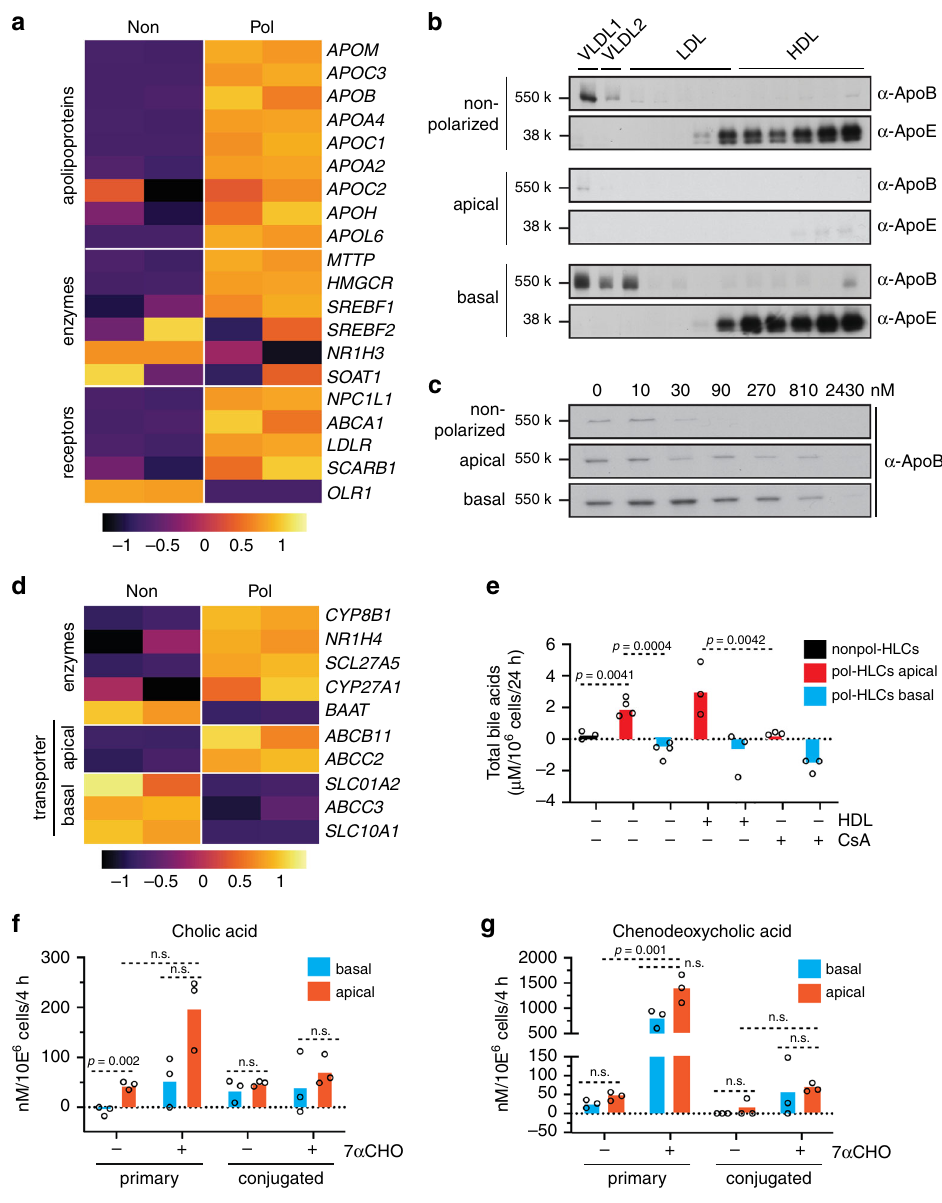
Fig. 3 Vectorial hepatic cargo secretion from polarized HLCs. a Heatmap of Z score-normalized CPM values for enzyme and transporter genes involved in lipoprotein metabolism in nonpol- compared with pol-HLCs ( n = biological replicates). b Density distribution of ApoB100 and ApoE secreted from nonpol- and pol-HLCs, labeled metabolically for 4 h with [ 35 S] methionine/cysteine. Supernatants from labeled cells were subjected to density gradient centrifugation followed by ApoB100 or ApoE immunoprecipitation of each fraction, separation by SDS-PAGE, and detection by [ 35 S] fl uorography. Results are representative of three independent differentiations. c Nonpol- and pol-HLCs were treated with indicated concentrations of the MTP inhibitor Lomitapide, prior to metabolic labeling, ApoB100-immunoprecipitation and detection. Results are representative of three independent differentiations. d Heatmap for Z score-normalized CPM values of enzyme and transporter genes involved in bile acid metabolism in nonpol- (Non) compared with pol- HLCs (Pol) ( n = biological replicates). e Total bile acid release from nonpol- and pol-HLCs treated for 24 h with 10 μ g/ml high-density lipoprotein (HDL) or 10 μ M cyclosporine A (CsA), as indicated ( n = biological replicates). f – g LC-MS analysis of primary and conjugated cholic acid ( f ) and chenodeoxcycholic acid ( g ) released from pol-HLCs treated with DMSO or 10 μ M 7 α -hydroxylcholesterol (7 α -CHO) for 4 h ( n = biological replicates). Statistical analysis was performed using a two-tailed unpaired t test with Bonferroni adjustment for multiple These results indicate that pol-HLCs exhibit improved lipoprotein synthesis, cholesterol to bile acid conversion, and bile acid release compared with nonpol-HLCs. In addition, the observed directional cargo release further con fi rmed the func-